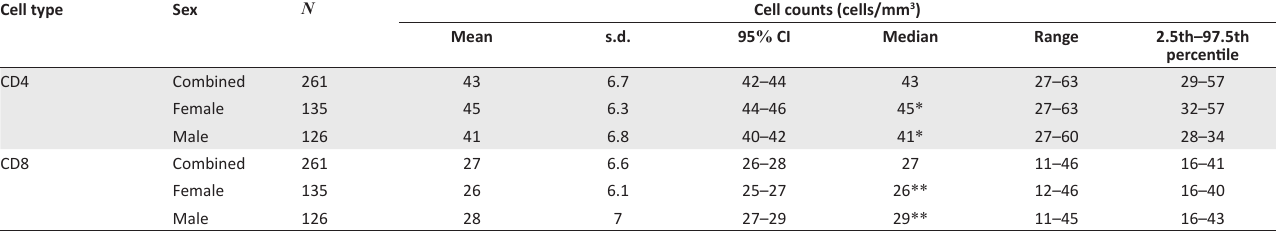
TABLE 3: CD4 % and CD8 % cells counts for healthy HIV-negative adults in Botswana. Cell type